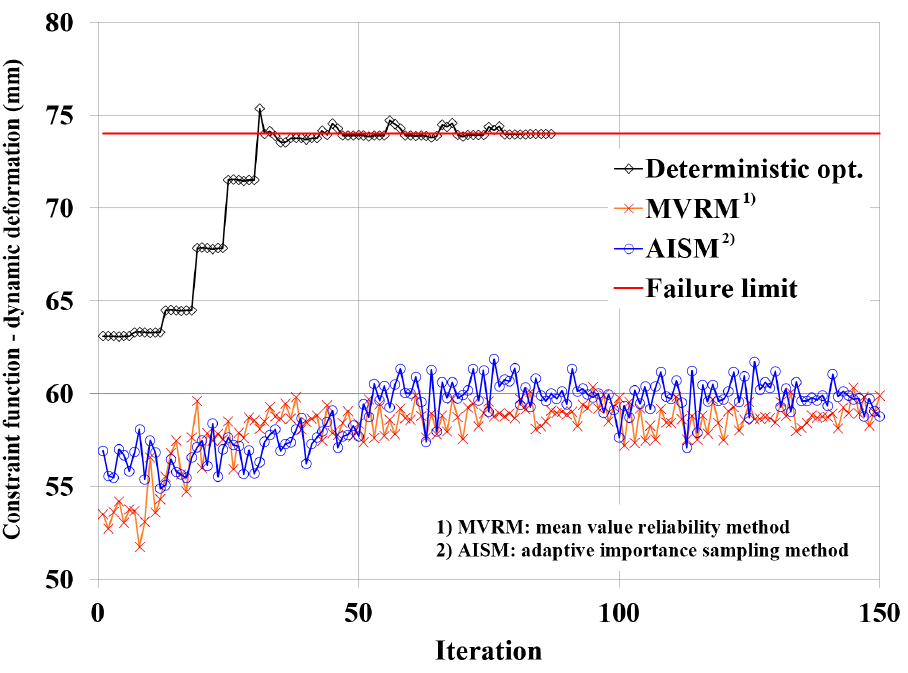
Figure 10. Convergence results of constraint functions.